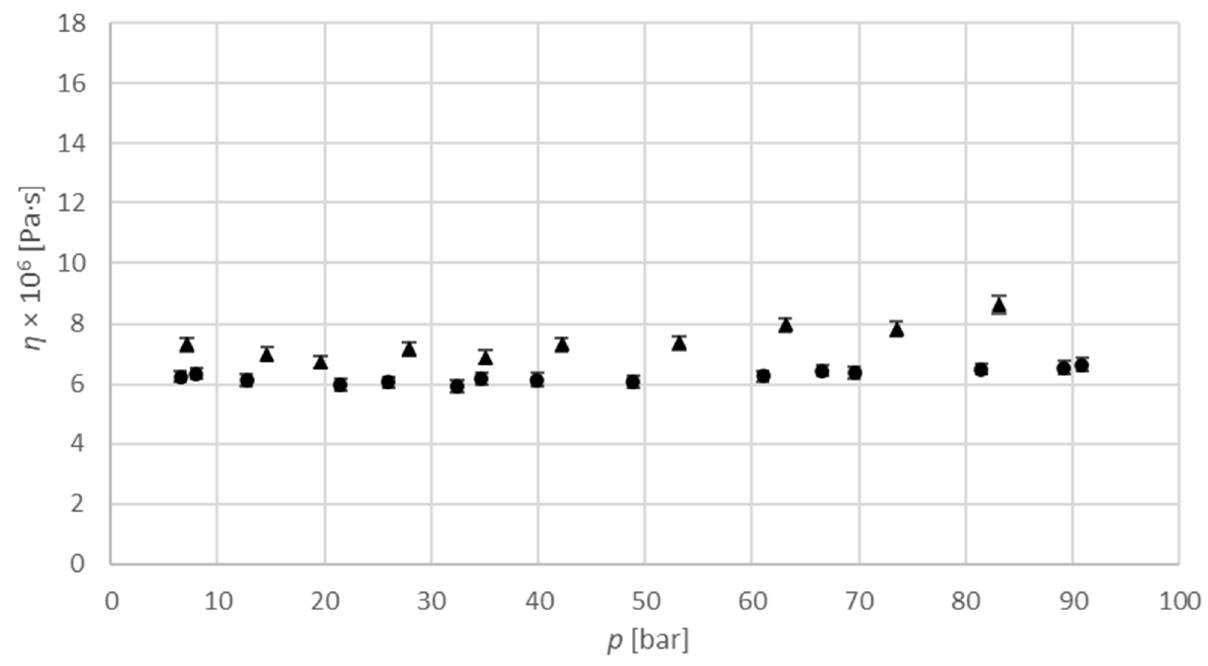
Figure 5. Viscosity of the CO 2 -saturated isopropanol binary system: , measured data at 313.15 K; , measured data at 313.15 K; , measured data at 333.15